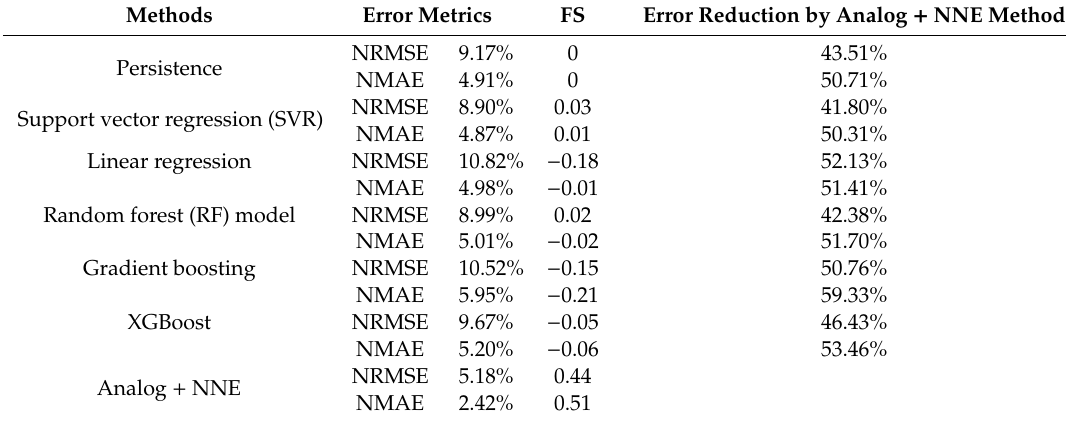
Table 3. Forecast performance comparison of the proposed method with the